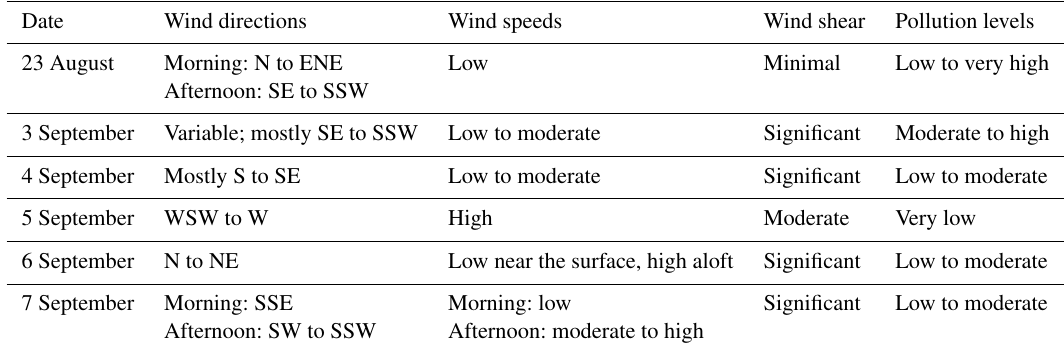
Table 3. Daytime wind and pollution conditions during the study